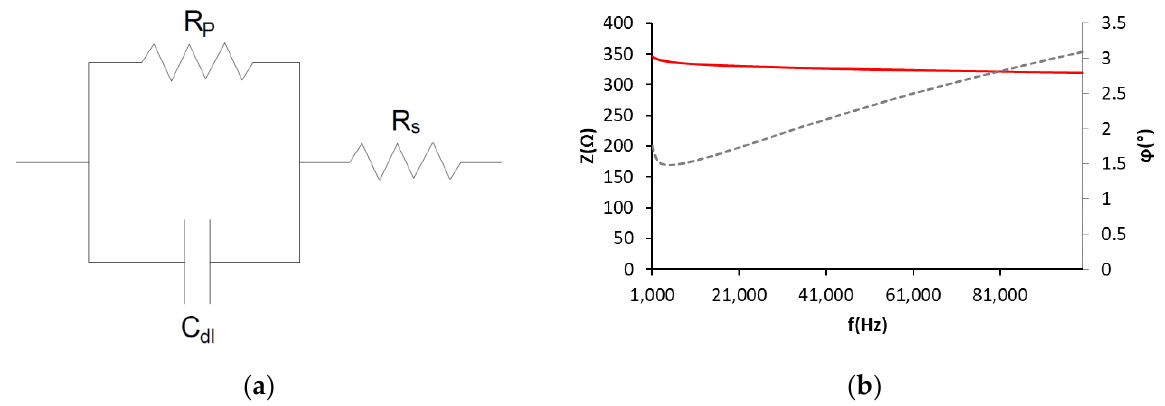
Figure 1. ( a ) Randles electric circuit (R s -R p /C dl ). ( b ) Example of the results obtained in the EIS test with the sensors. Z impedance, φ phase of impedance.